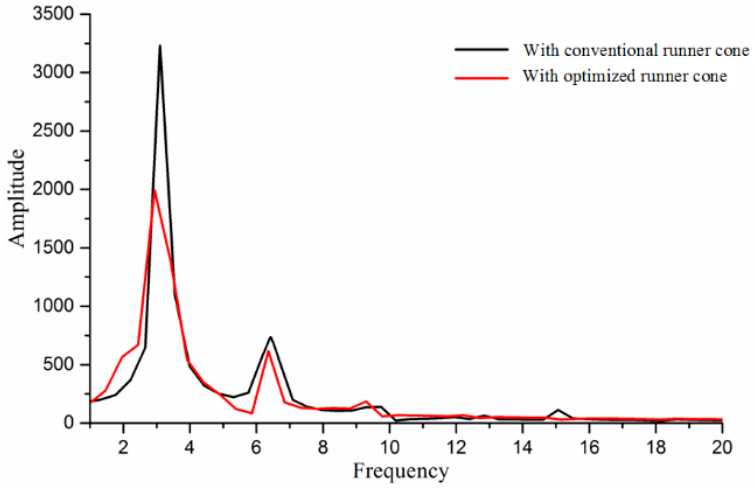
Figure 5. Pressure fluctuation at σ = 0.12.